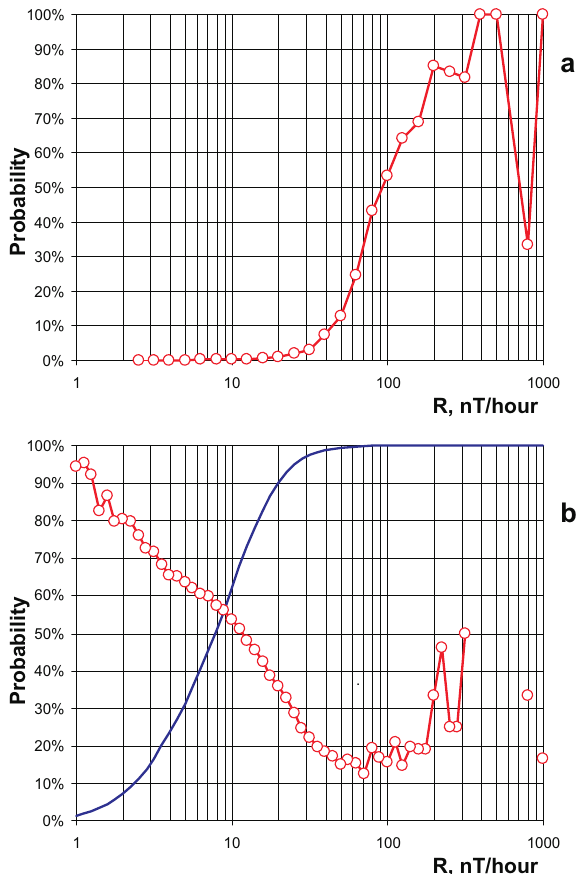
Fig. 6. Conditional probabilities for Chambon-la-Forˆet: (a) P (R(k + 1 ) > 50nT/hour | R(k)) ; (b) P (R(k + 1 ) > R(k) | R(k)) , and the empirical distribution of R (blue line), i.e. unconditional probability P (R(k + 1 ) ≤ R)